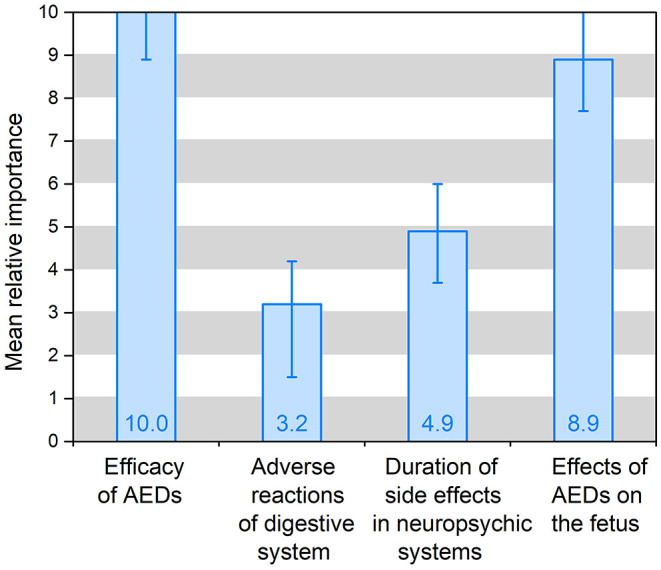
Mean relative importance for treatment of AEDs (N = 151).